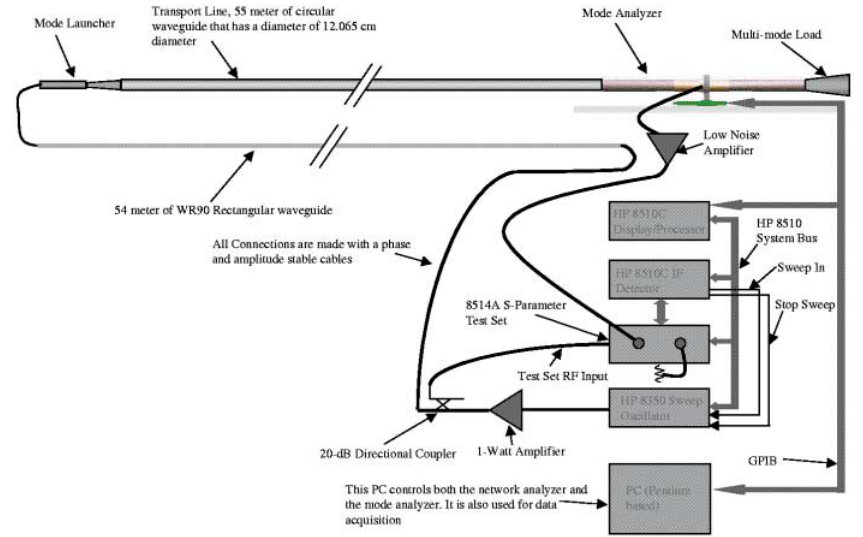
FIG. 4. (Color) Typical measurement